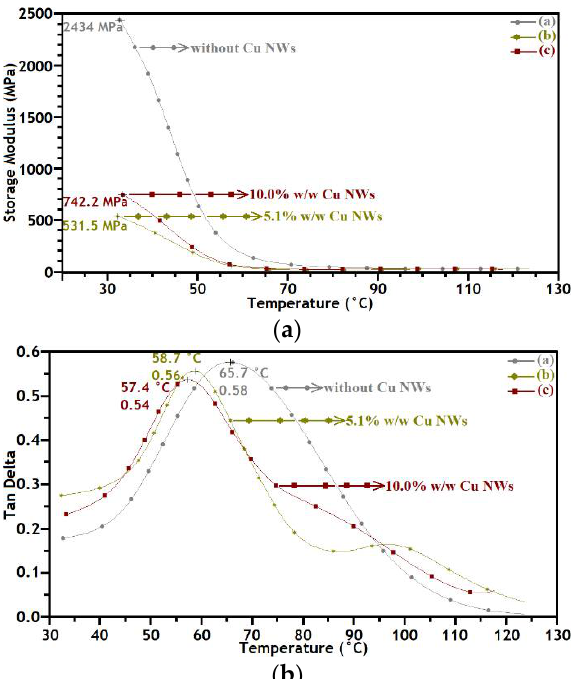
Figure 9. DMA curves of the substrates manufactured of “clear FLGPCL 02” resin without Cu NWs ( ◦ ), with Cu NWs at 5.1% w / w ( ∗ ), and 10.0% w / w ( (cid:3) ). ( a ) Storage modulus ( E (cid:48) ) and ( b ) loss factor (tan δ ) as a function of temperature.